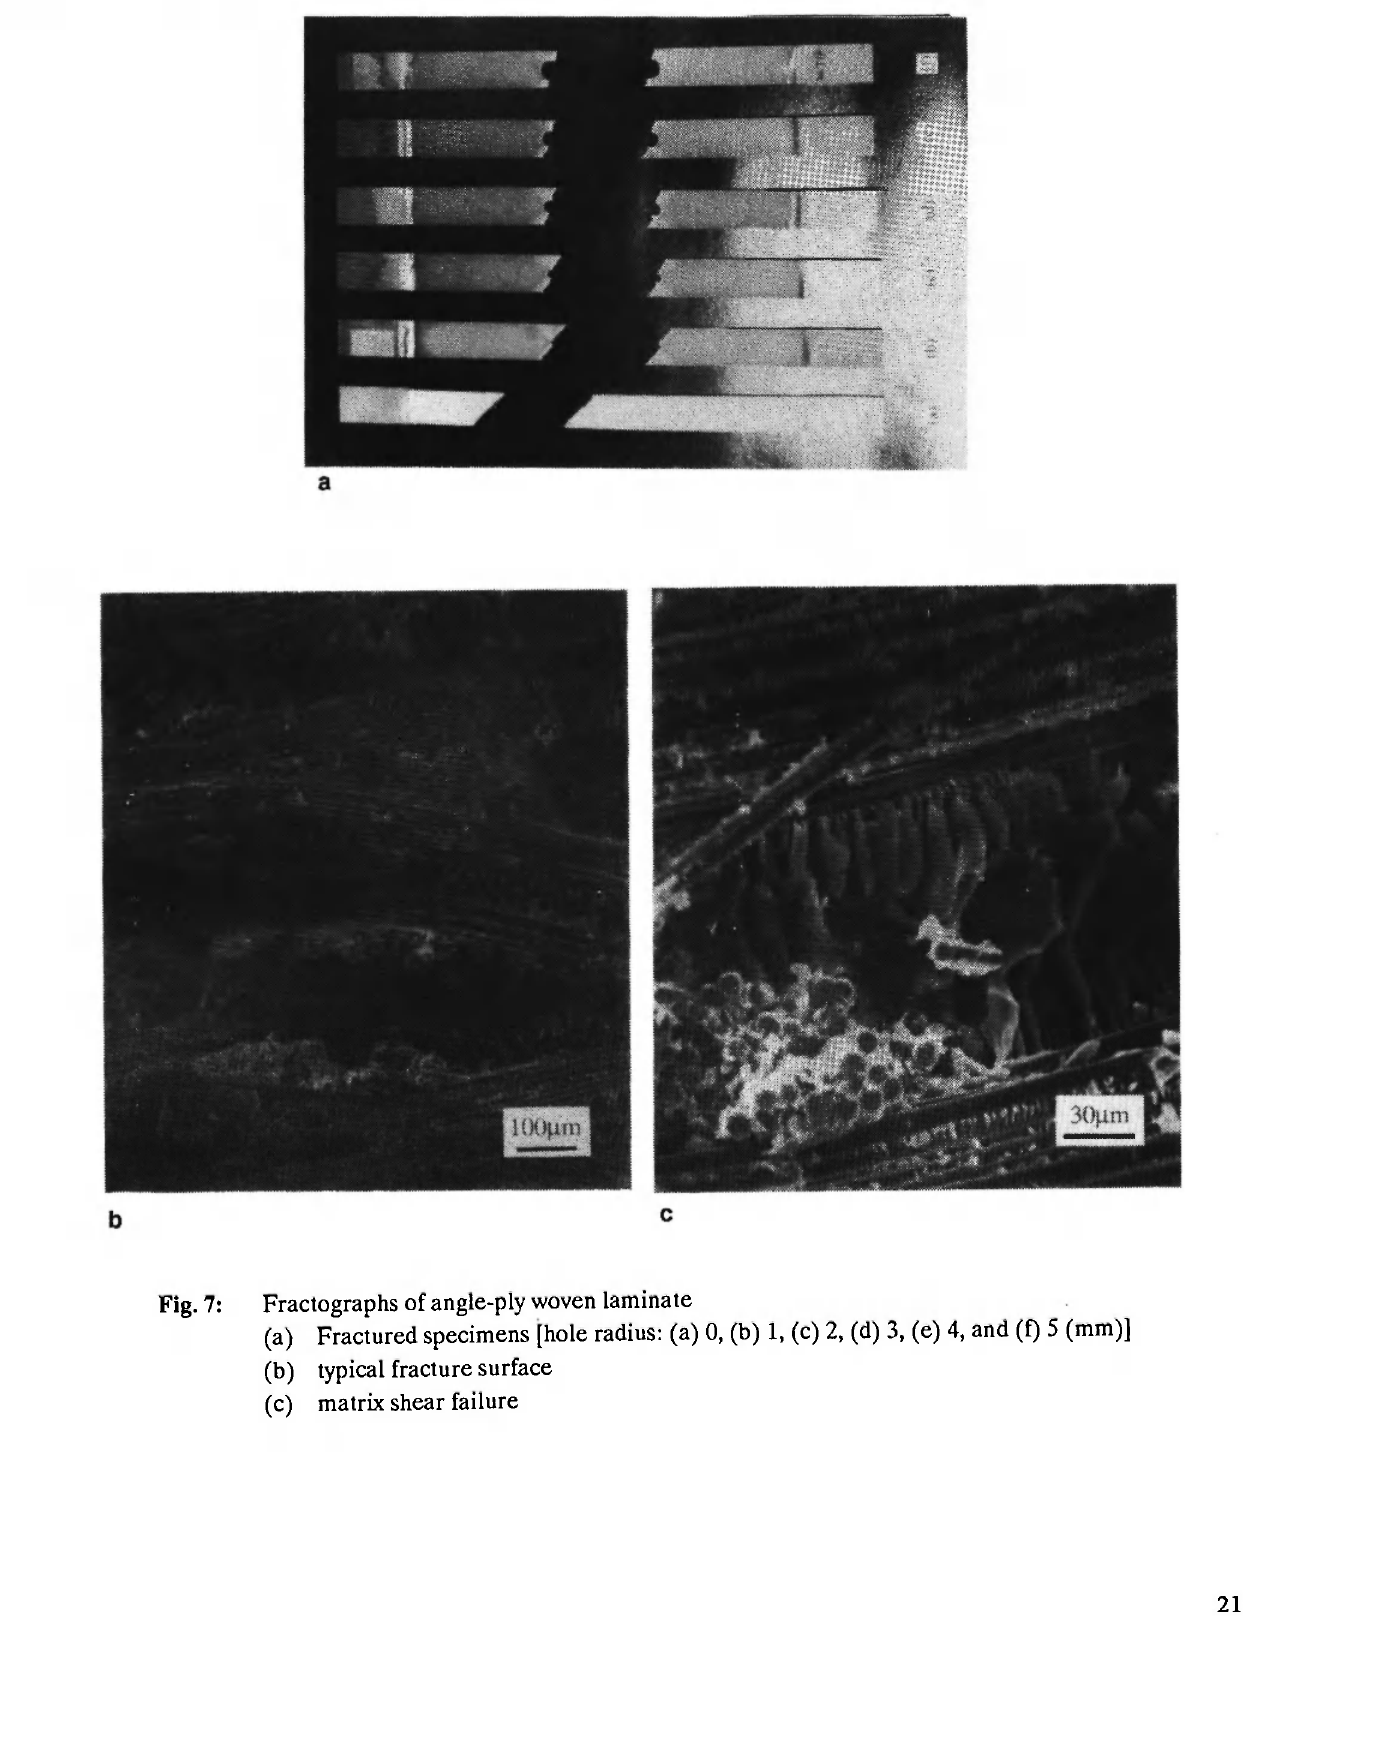
Fig. 7: Fractographs of angle-ply woven laminate (a) Fractured specimens [hole radius: (a) 0, (b) 1, (c) 2, (d) 3, (e) 4, and (f) 5 (mm)] (b) typical fracture surface (c) matrix shear